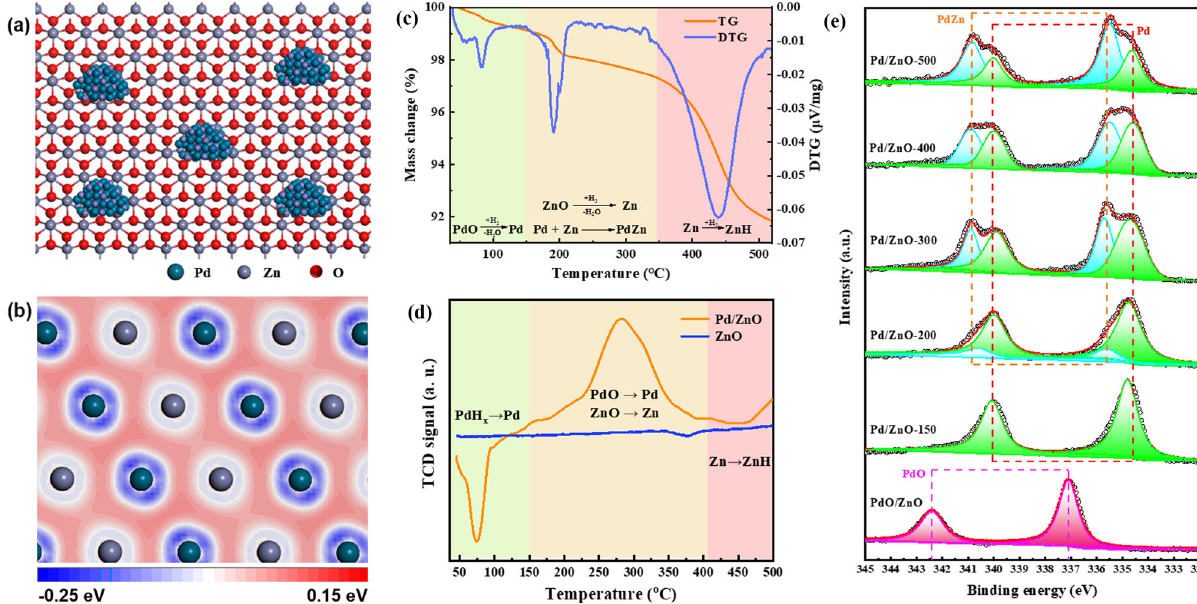
Fig. 1 Structure characterization of intermetallic PdZn. a Schematic illustrating PdZn/ZnO catalyst. b Deformation density of intermetallic PdZn. c TG/ DTG pro fi les for the Pd/ZnO sample under 5 vol% H 2 /Ar from room temperature to 520 °C with 5 °C min − 1 . d H 2 -TPR pro fi les of Pd/ZnO and ZnO samples in 10 vol% H 2 /Ar up to 500 °C with 5 °C min − 1 . e XPS spectra of Pd 3 d region of unreduced PdO/ZnO and Pd/ZnO- T